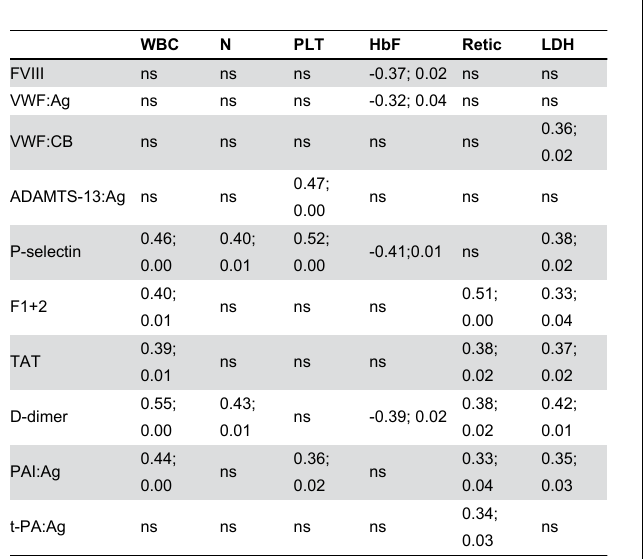
Table 3. Significant correlations between hematologic and coagulation parameters in patients with SS-Sβ°.